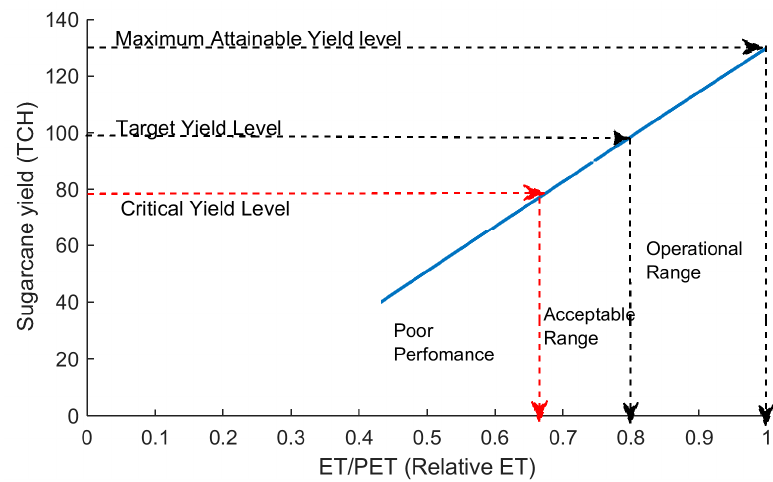
Figure 4. The linear relationship between sugarcane yield and relative ET to establish the target and critical level of relative ET